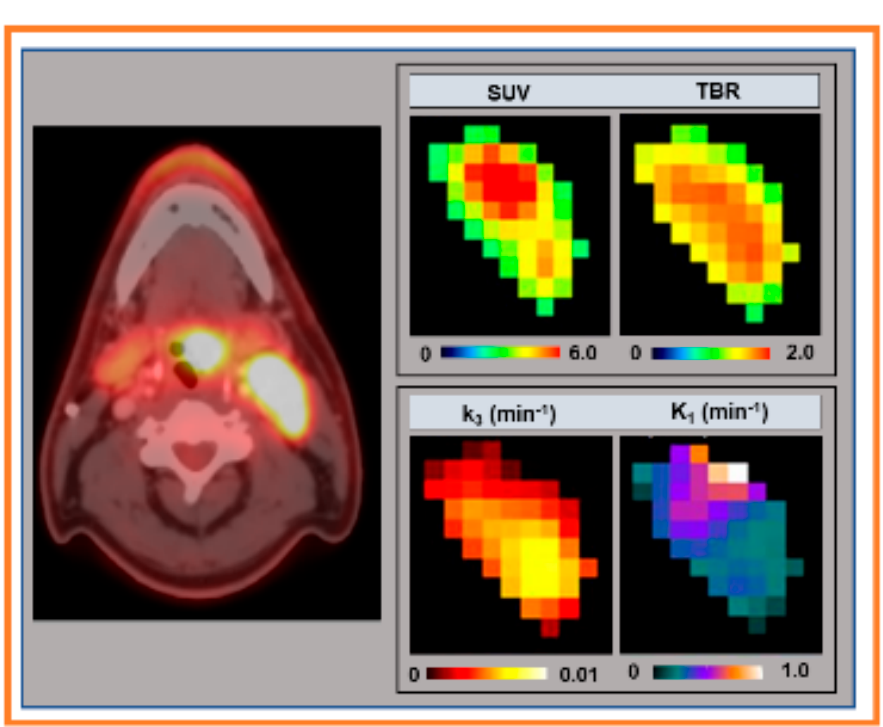
Figure 3. Left column: Representative axial images of 18 F-fluoromisonidazole ( 18 F-FMISO) positron emission tomography (PET/CT) from HPV-positive head and neck squamous carcinoma patient. Right column: 18 F-fluorodeoxyglucose-PET/CT derived standard uptake value (SUV) and FMISO- PET derived tumor to blood ratio (TBR), k 3 , and K 1 maps. Representative DW, T 1 -weighted image, and QI metrics derived from IVIM and FXR model are displayed in Figure 4. The representative MRI images were from the same pa- tient shown in Figure 2.